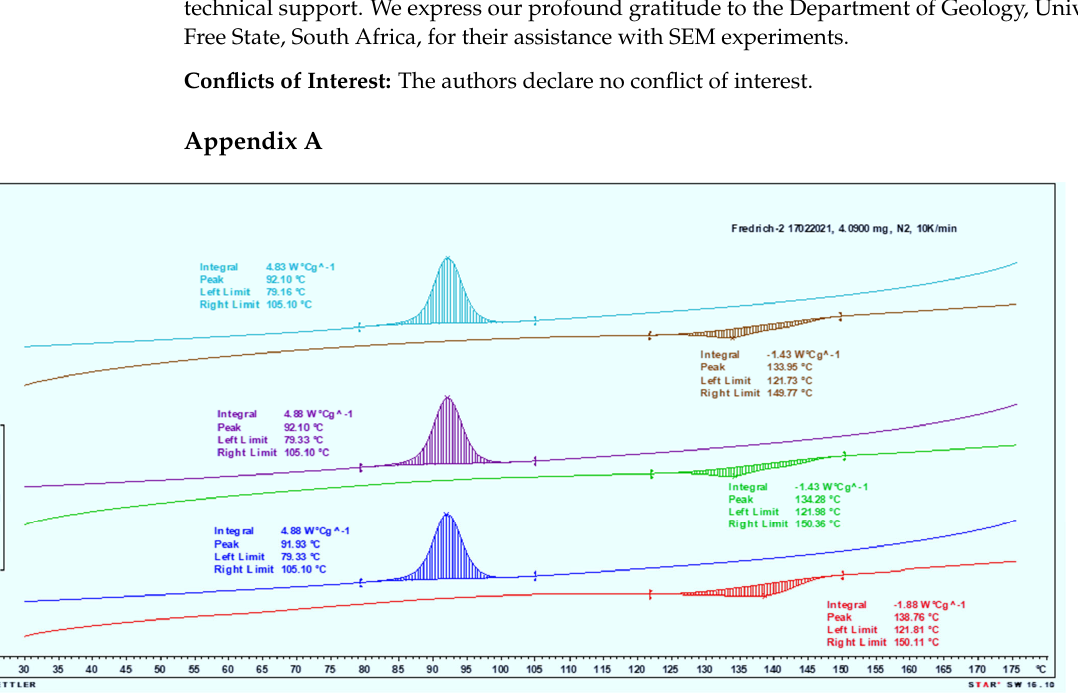
Figure A1. DSC curve for fresh powder material.